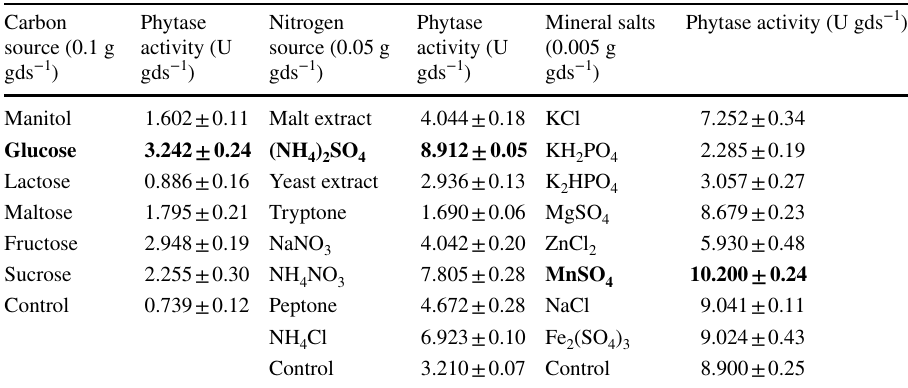
Table 3 Effect of different nutritional parameters on phytase production